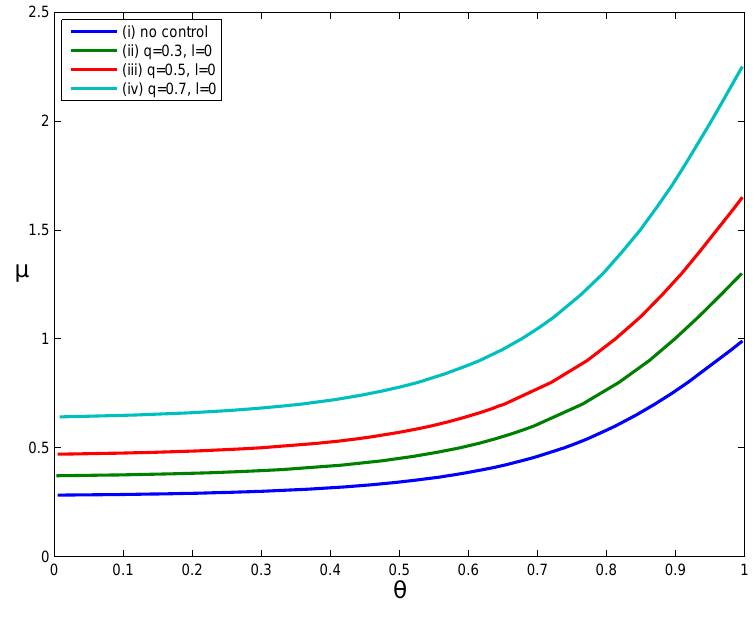
Figure 2. The effect of voluntary